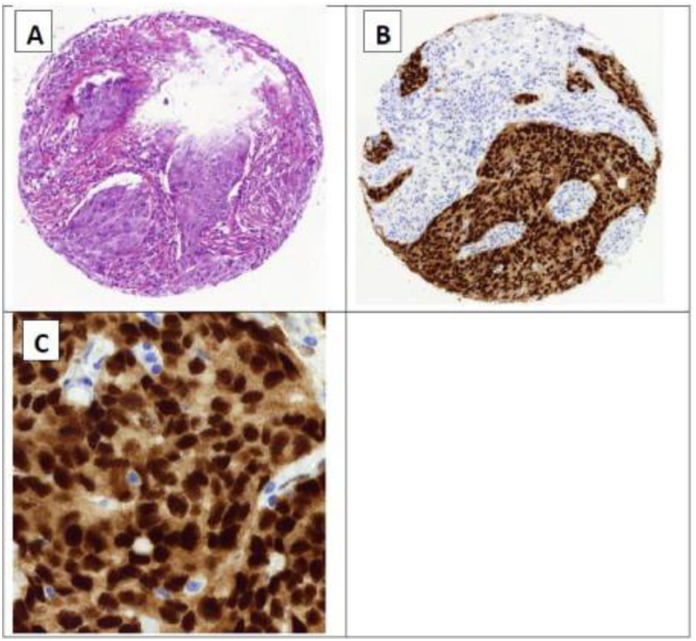
Representative images of AR positive immunohistochemistry in breast tumor tissue array.A, H&E staining (10X); B, immunostaining (10X); C, immunostaining of a specific area (40X).